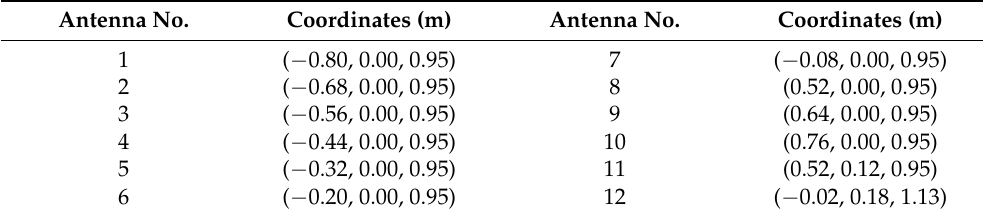
Table 1. Actual Coordinates of twelve Vivaldi antennas on the CE-5 Lander. Antenna No. Coordinates (m) Antenna No.